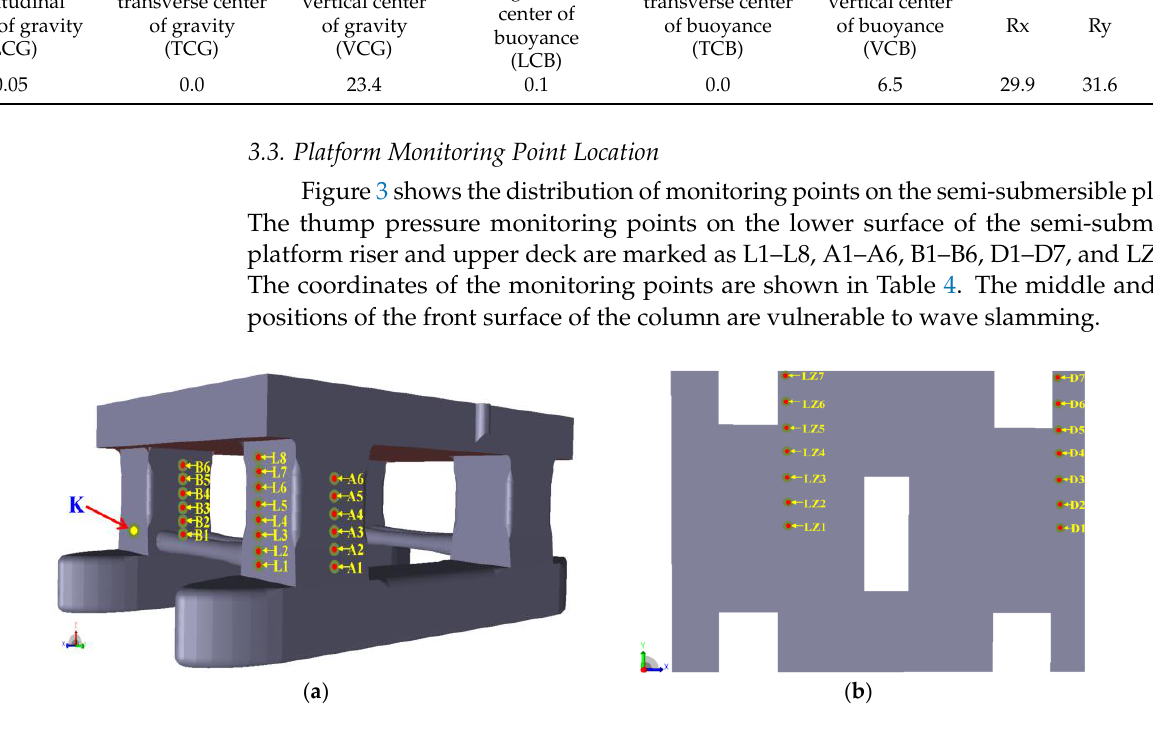
Figure 3. Distribution of the monitoring points. ( a ) Column monitoring points. ( b ) The bottom of deck box monitoring points. Table 4. The coordinates of the monitoring points.